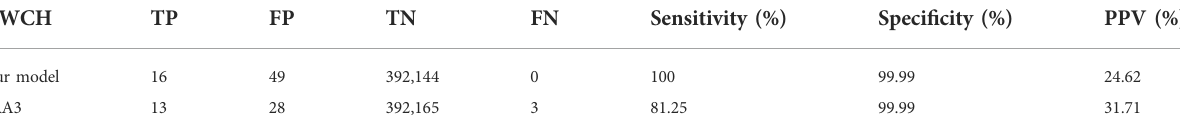
TABLE 5 Comparison with LRA3 in the NWCH